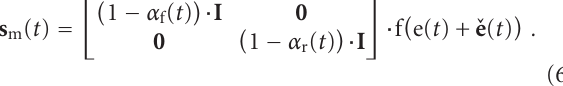
Figure 3: The focus residual α f during a